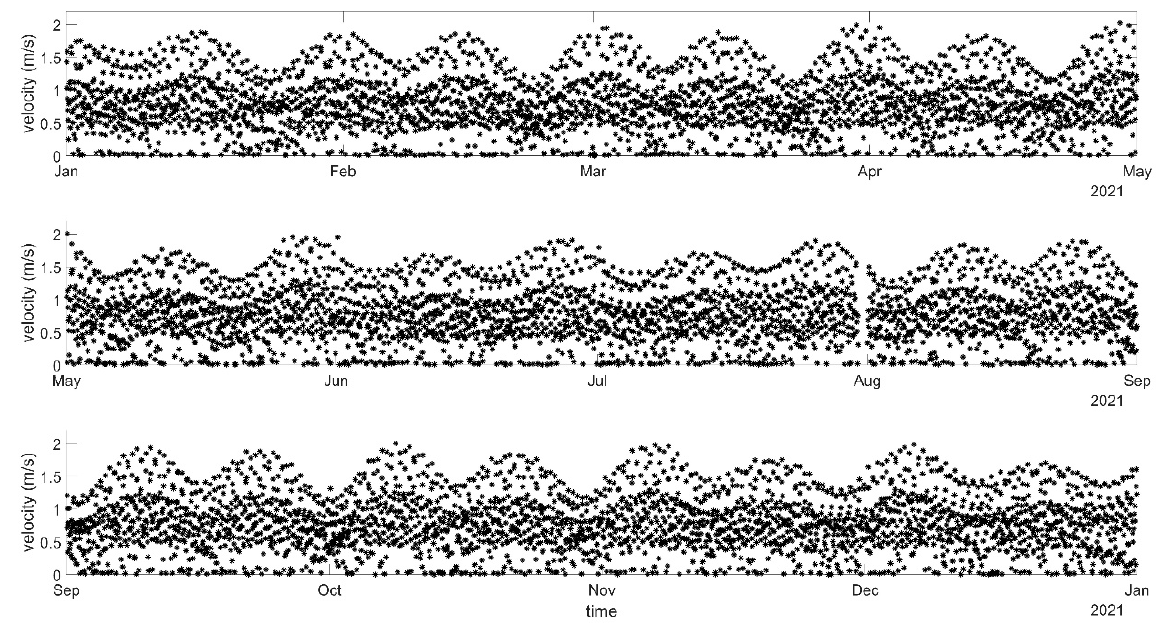
Figure 7. Depth average modeled velocity currents of point A during 2021 in Buenaventura Bay.